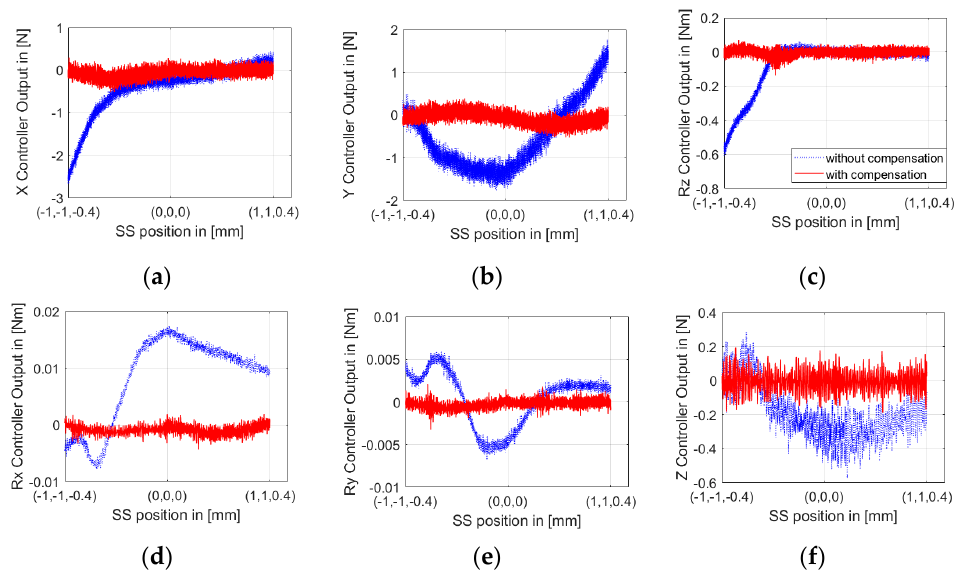
Figure 15. SS controller forces in ( a ) X, ( b ) Y, ( c ) Z, ( d ) Rx, ( e ) Ry, and ( f ) Rz DoF with and without PDDF compensation.